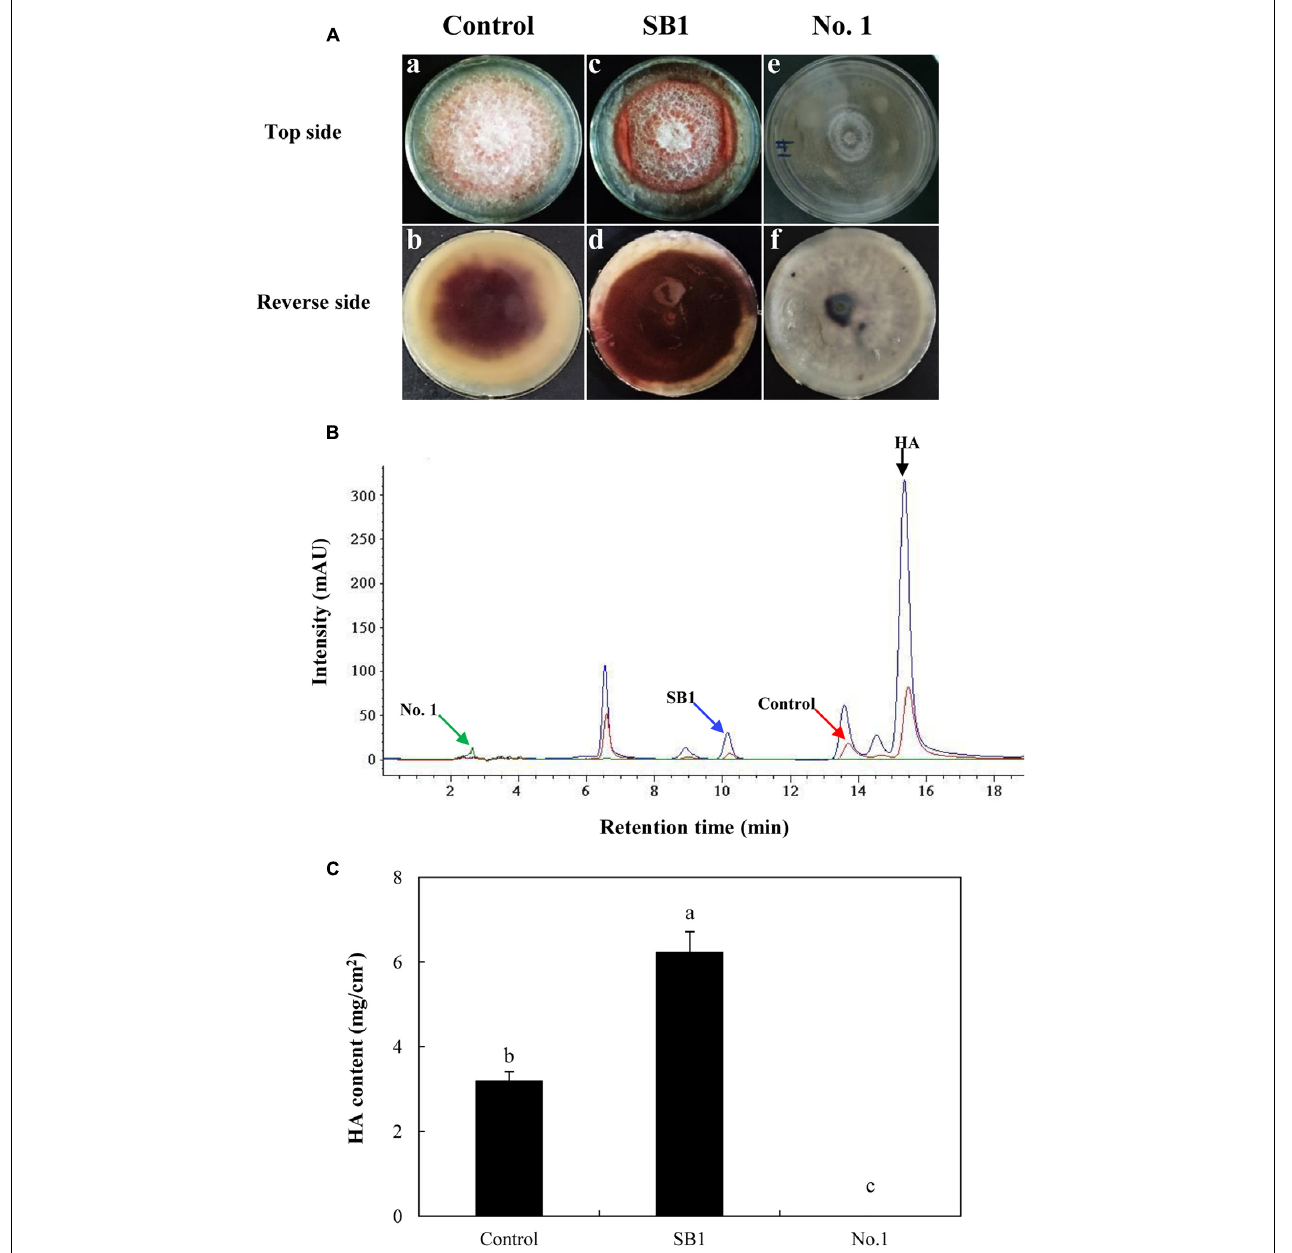
FIGURE 5 | (A) The effect of live bacteria ( P. fulva SB1 and B. cereus No. 1) on the growth and red pigment secretion of Shiraia sp. S9. The blank control group without treatment (a and b). The treatment group treated with live SB1 cells (c and d) and No. 1 cells (e and f). (B) The retention time of HA of Shiraia sp. S9. (C) The HA content of Shiraia sp. S9 in PDA plate. A small piece (5 mm × 5 mm) of the strain was placed in the center of a 10-cm PDA plate at 28 ◦ C for 4 days. The single colony of bacterium was inoculated in LB at 37 ◦ C on a rotary shaker at 200 rpm for 12 h. Then, bacterial suspension (10 µ l) was streaked in two parallel straight lines on PDA at 28 ◦ C for 10 days, approximately 7 cm apart from each other. Values are mean ± SD from three independent experiments. Different letters above the bars mean significant differences ( p <